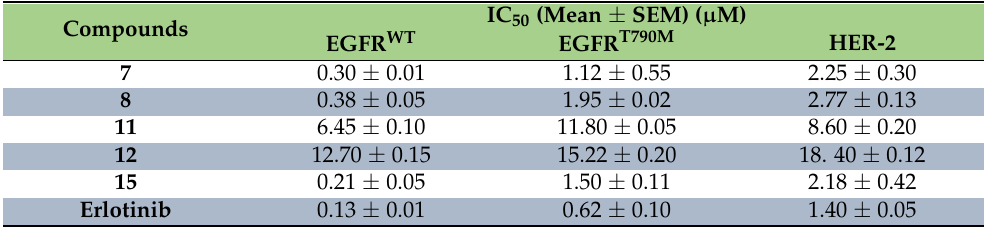
Table 2. Kinase inhibition assessment of the highly potent derivatives 7 , 8 , 11 , 12 and 15 (IC 50 in µ M) against EGFR WT , EGFR T790M and HER-2